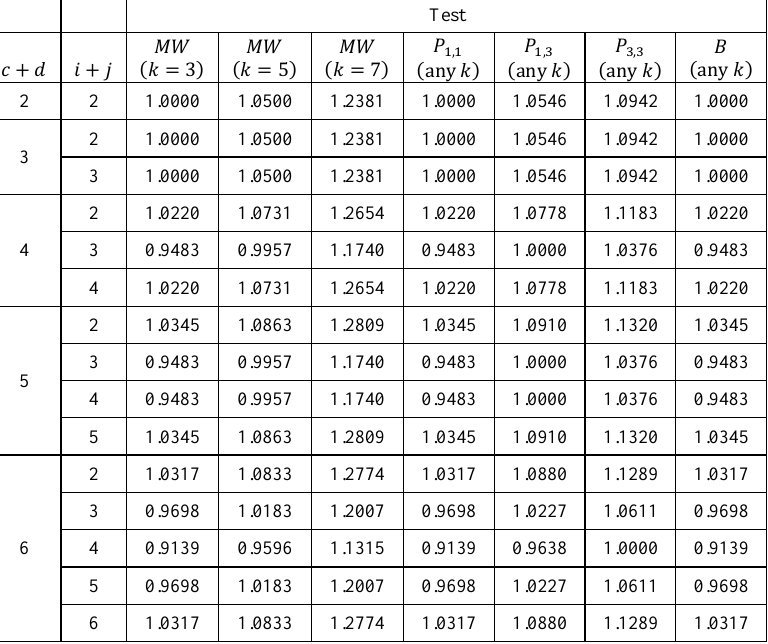
Table 3. AREs of 𝑇 for Normal distribution w.r.t. different 𝑐,𝑑;𝑖,𝑗